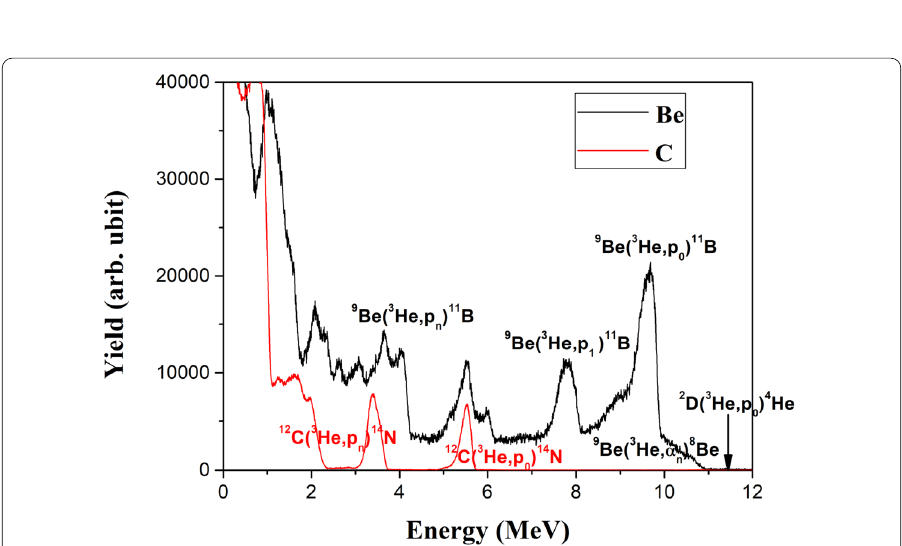
Figure 9 Nuclear reaction spectra obtained with a 3 MeV 3He + beam for 12 C( 3 He,p) 14 N and 9 Be( 3 He,p) 11